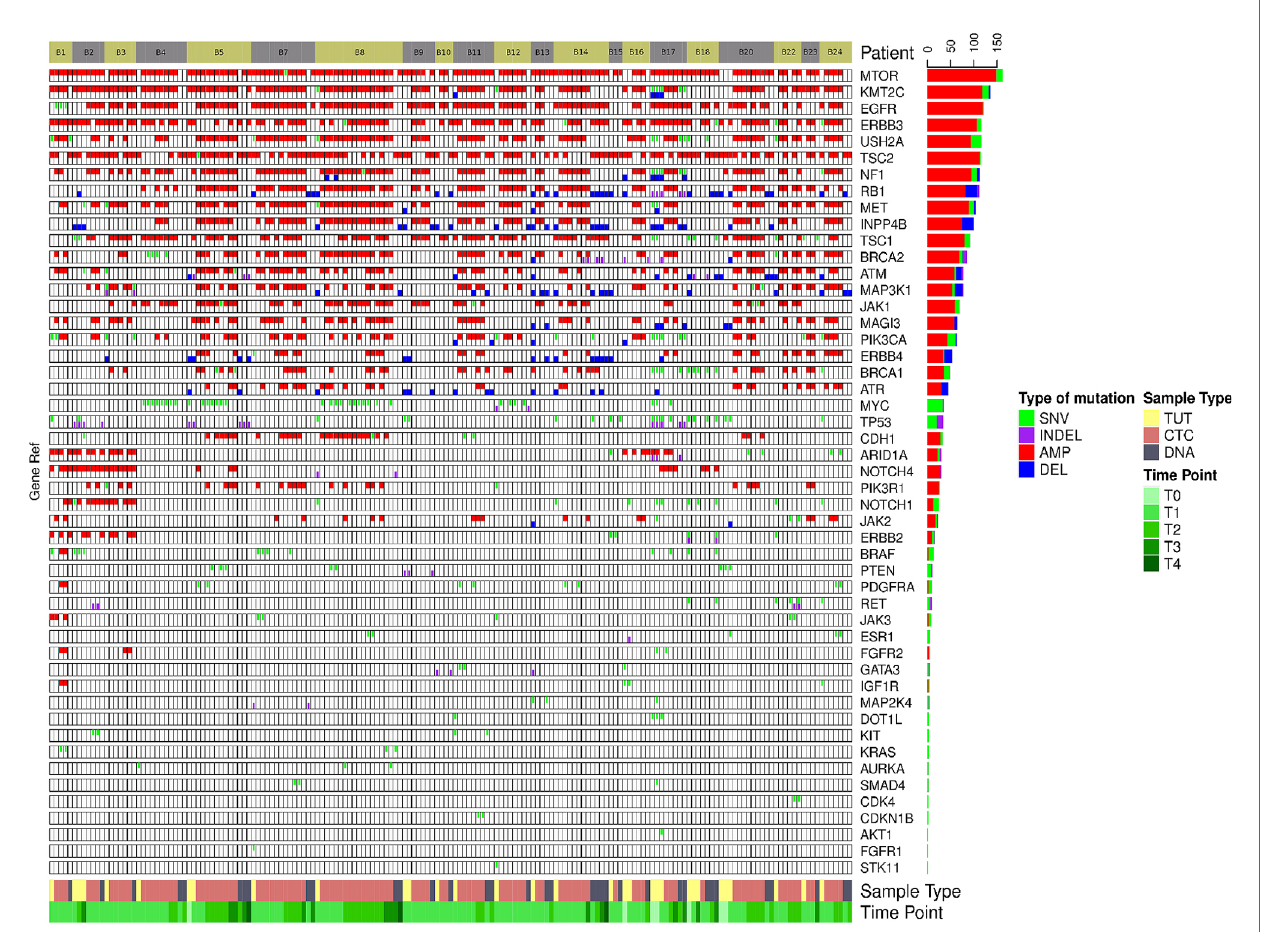
FIGURE 3 | The genomics alteration detected in the breast cancer samples. The rectangle panels and colors are as described in Figure 2 . In addition, the time point of the serially collected samples for selected patients are represented by the different tones of green color at the bottom panel from 1 st (T1) up to 4 th time point (T4) during the course of this study. T0 indicates the time point that the tumor was collected before this